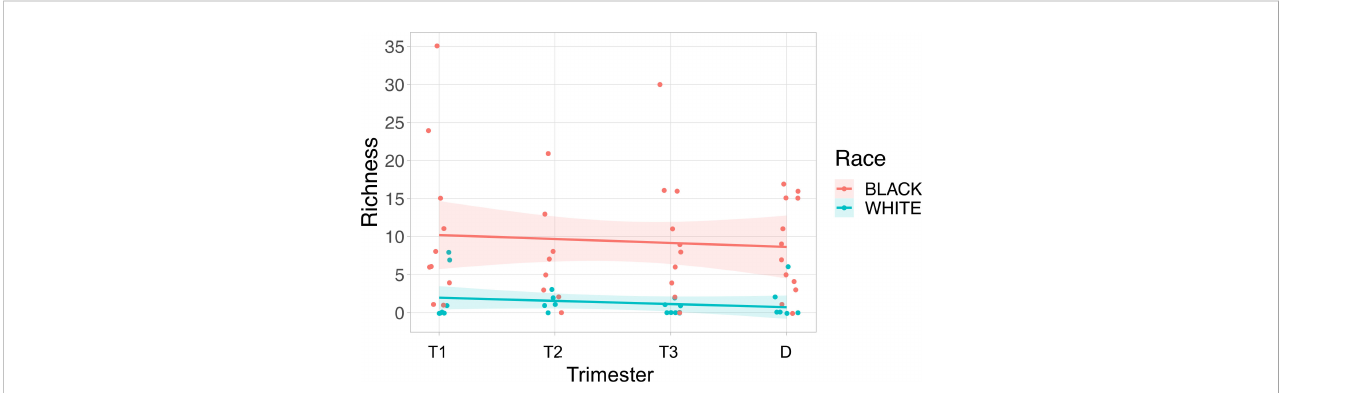
FIGURE 4 Viral richness in maternal plasma is higher in Black subjects than White subjects. Viral richness (the number of different viruses detected) is plotted on the y-axis, and the time point the sample was collected was plotted on the x-axis. The fi tted line is plotted with the 95% con fi dence interval shaded. Black subjects are plotted in pink, and White subjects are in blue. T1, Trimester 1; T2, Trimester 2; T3, Trimester 3; D,